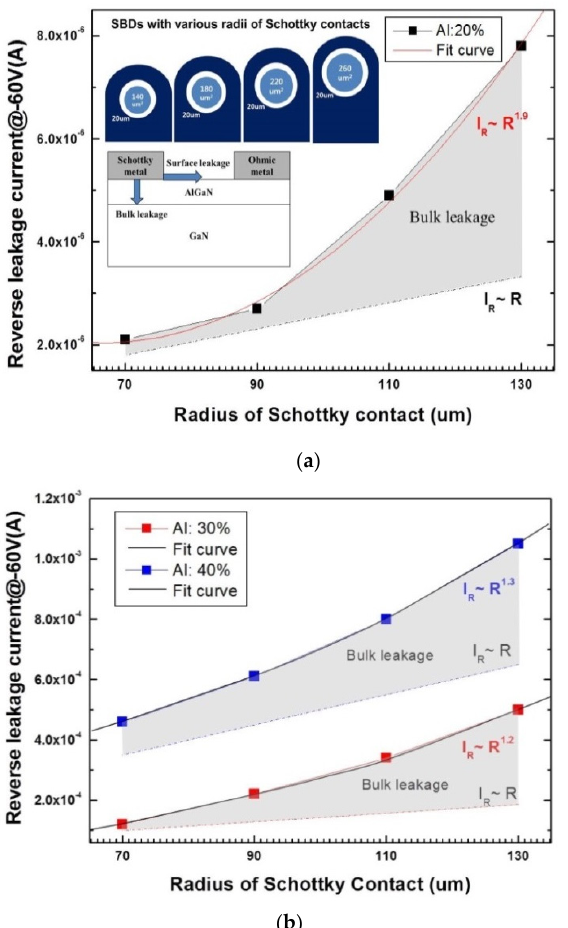
Figure 2. Reverse leakage current for Al x Ga 1 − x N/GaN SBD with Al composition of 0.2 ( a ), 0.3 ( b ), and 0.4 ( b ) at − 60 V according to size of Schottky diameter. The inset of ( a ) shows the schematic illustrations of SBDs with various radius of Schottky contacts including vertical and lateral leakage current